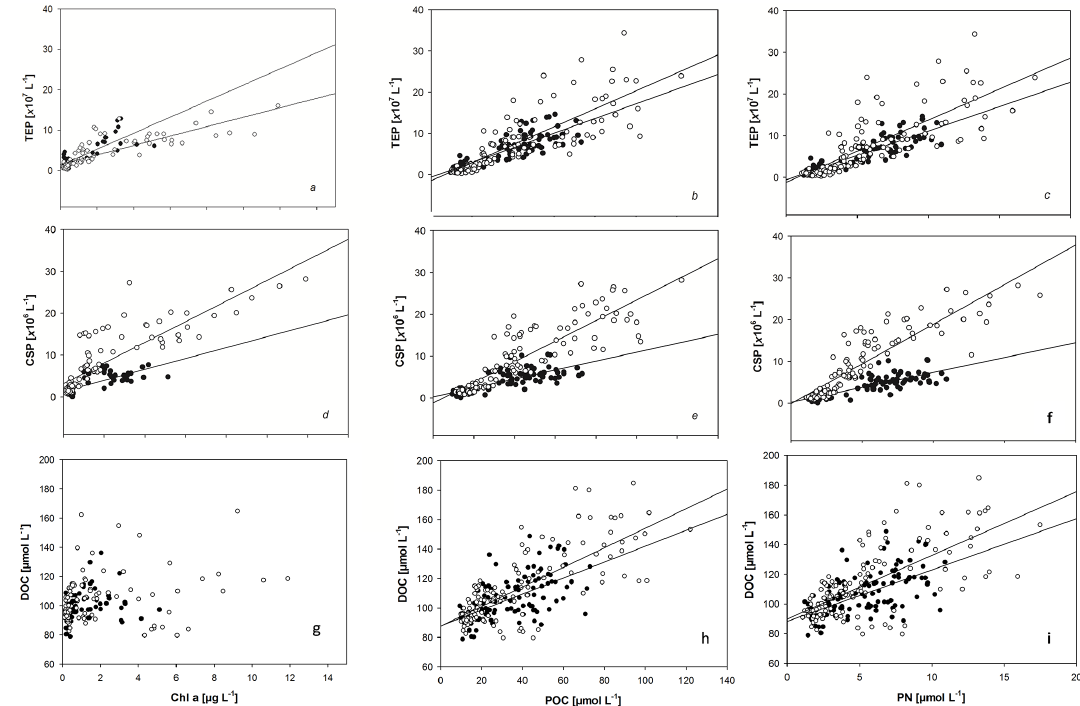
Figure 7. Relationships between organic components during Varied P and Varied N . Solid symbols: data obtained during Varied P ; open symbols: data obtained during Varied N . Linear regressions with Chl a include data of samplings 1, 2 and 5 for Varied P and 1–6 for Varied N . Linear regressions with POC and PN include data of all samplings. Information on regression statistics is given in Table